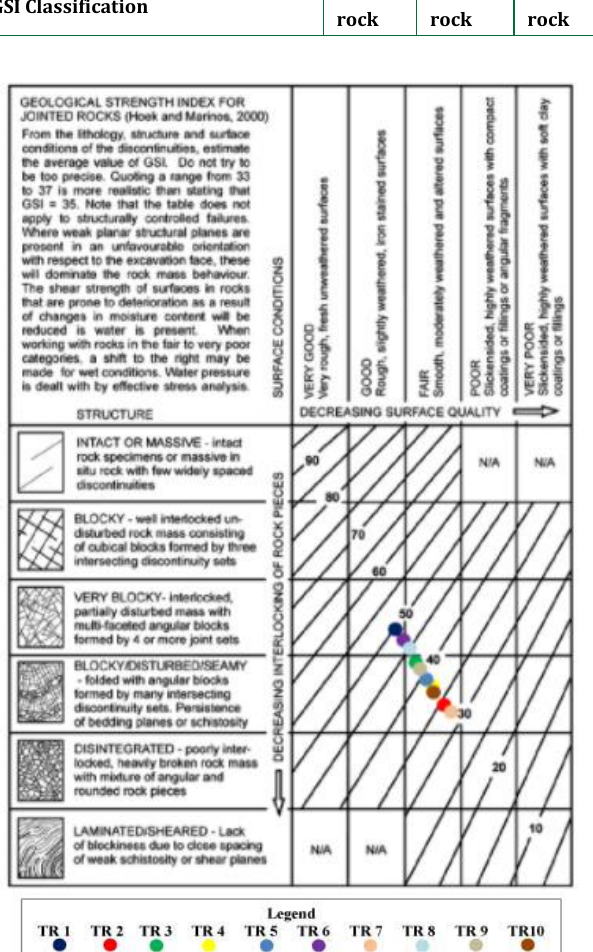
Figure 3: The GSI estimation chart from the geological observations (Diagram above is based on Hoek & Karzulovic,